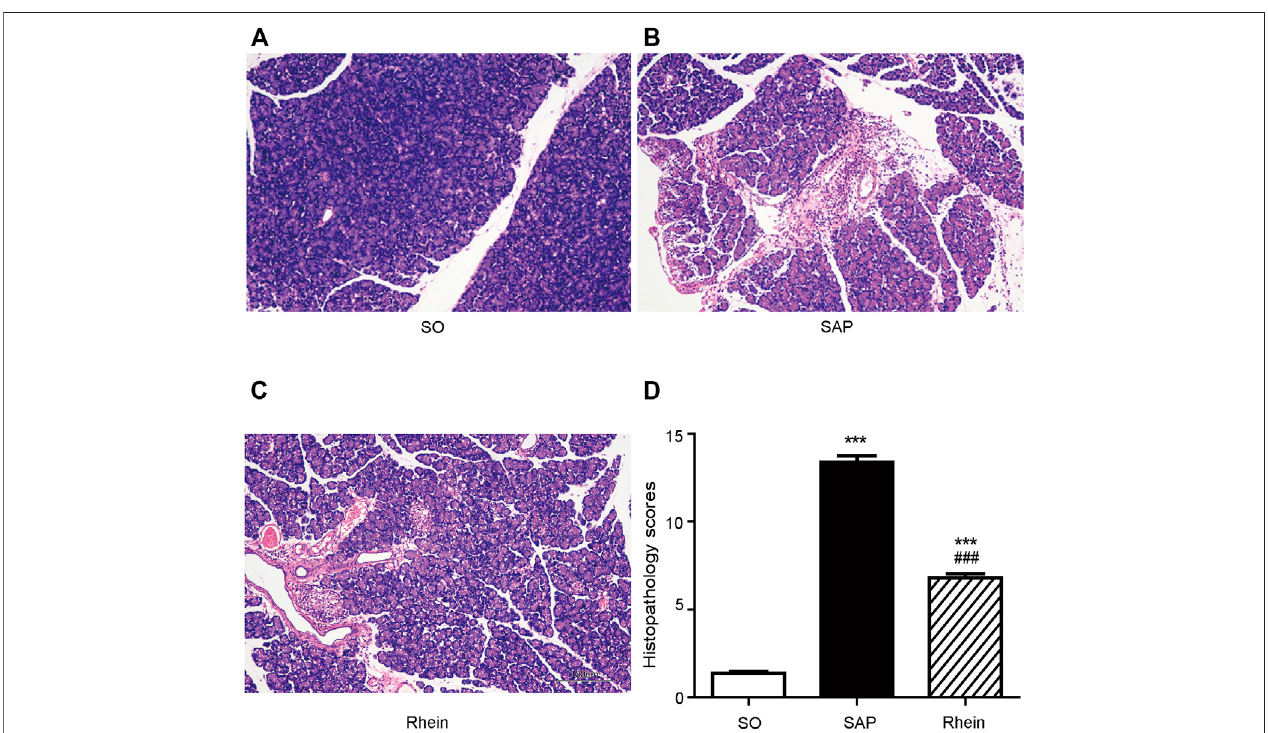
FIGURE 4 | Histological analysis of SAP. ( A – C) Morphological analysis of H&E-stained sections; Scale bar: 100 μ m. (D) Pathological scores of pancreatic tissue sections. Dataareexpressed asmean±SD( n =3pergroup).Signi fi cancebetweengroupswasevaluatedbyonewayanalysisofvariance(ANOVA)followedbyaTukey post hoc test. * p < 0.05, ** p < 0.01 and *** p < 0.001 compared with the SO group; # p < 0.05, ## p < 0.01 and ### p < 0.001 compared with the SAP group. SO, sham operation; SAP, severe acute pancreatitis; H&E, haematoxylin and